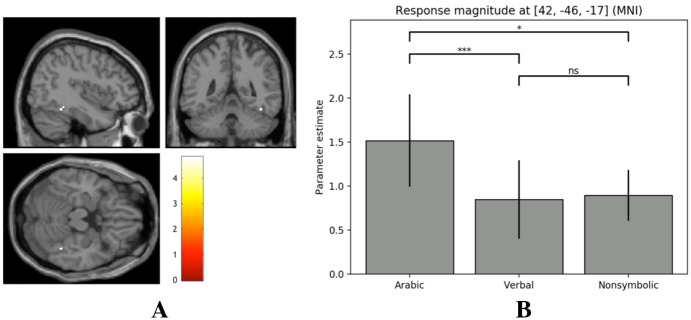
VNFA cluster activity and response magnitudes.(A) Slices illustrate VNFA cluster activity at z = -17 across conditions (p < 0.05 FWE). (B) Average parameter estimates for this cluster across conditions.